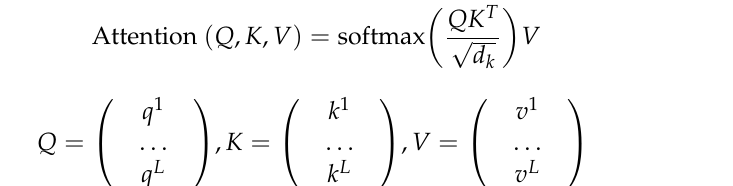
Figure 4. The input is L nodes x i , i = 1, 2, . . . , L − 1, L , mapped to a i by the input embedding operation. W q , W k , W v are trainable parameter matrices, and a i can obtain the correspond- ing q i , k i , v i by multiplication with the three transformation matrices W q , W k , W v . MSA in Figure 3 developed from self-attention by using MSA to be able to combine information learned from different head parts [23]. MSA is calculated as shown in Equations (5) and (6) with W o , W Q , W K , W V as trainable weight matrices and j = 1, . . . , h , h as the i i i number of heads in the